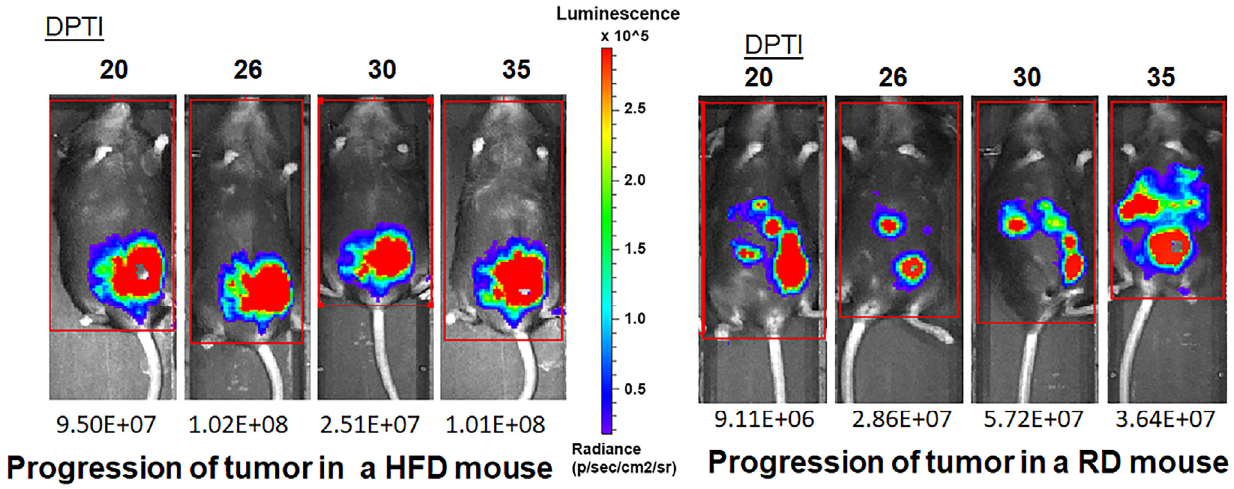
Figure 4. Bioluminescence imaging by IVIS showed distant metastases in RD-fed mice ( right panel) at earlier point after tumor implantation compared to HFD mice. The primary tumors were relatively larger in size in HFD mice ( left panel) starting as early as 20 days post tumor implantation (DPTI). C57BL/6J (female, 4 weeks old, n = 6/group) mice fed on RD or HFD for a short period of 4 weeks were subcutaneously injected with luciferase expressing E0771-tdTom-Luc (2.5 × 10 5 ) cells on the right fat pad of the fourth mammary gland and imaged twice a week after tumor implantation.